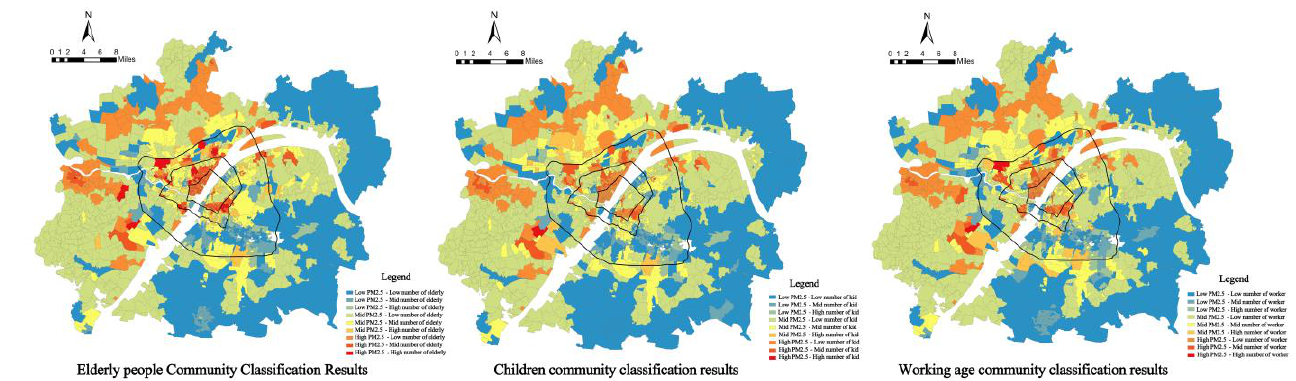
Figure 8. Community PM 2.5 pollution exposure risk classification results .